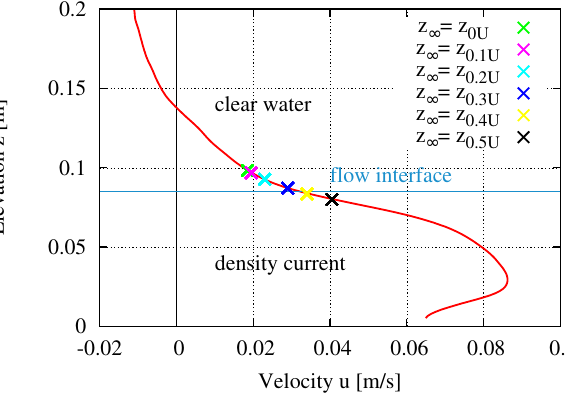
Figure 2. Comparison between the value of the experimental head velocity and the value of the velocity of the body averaged in time.